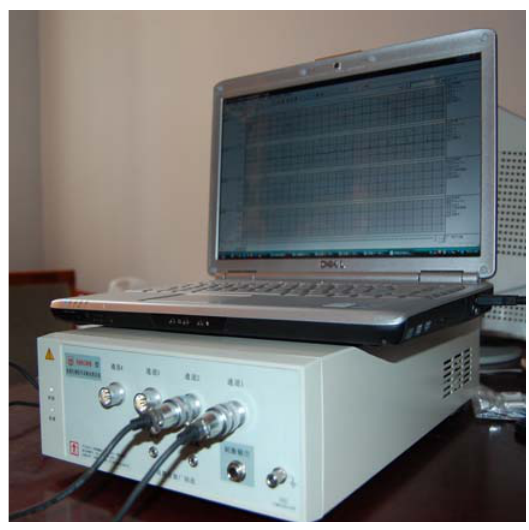
Fig.4. Multi-channel physiological signal acquisition